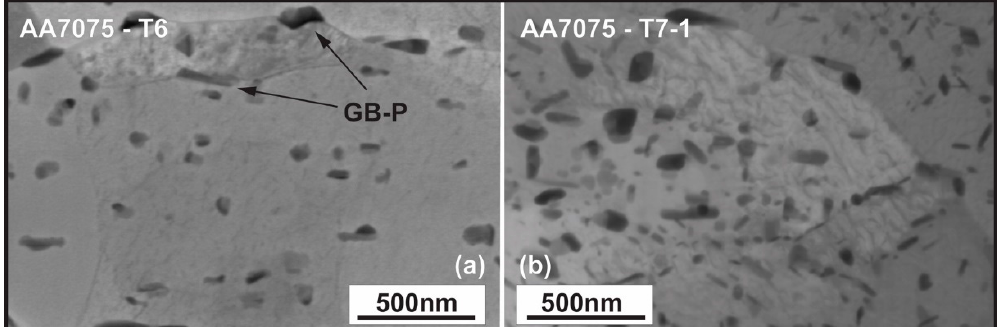
Figure 4. STEM investigation of ( a ) T6 (120 °C for 20 h) and ( b ) T7-1 (220 °C for 3 h).